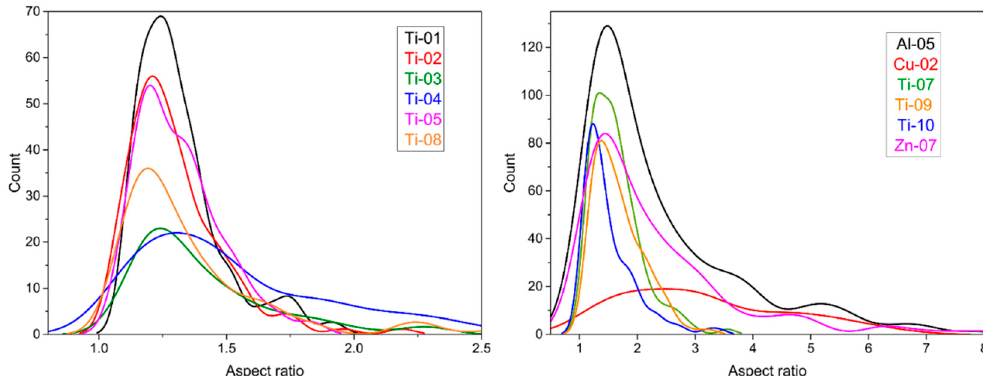
Figure 6. Smoothed histogram plots for aspect ratio for representative metal oxides nanomaterials. TiO 2 samples with mean aspect ratios < 1.5 are shown in the left panel and several samples with higher mean aspect ratios are shown in the right panel.